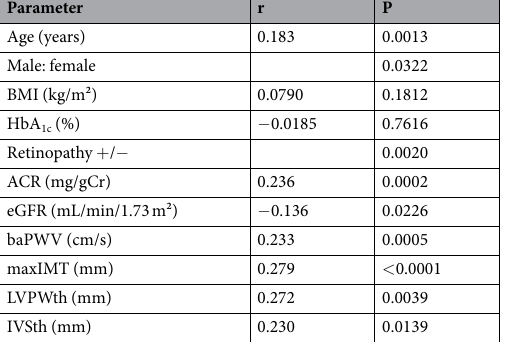
Table 2. Correlation between patient parameters and serum level of α 2 -macroglobulin: univariate analysis. BMI = body mass index, ACR = albumin:creatinine ratio, eGFR = estimated glomerular filtration rate, baPWV = brachial–ankle pulse wave velocity, maxIMT = maximal intima-media thickness. LVPWth = left ventricular posterior wall thickness, IVSth = interventricular septum